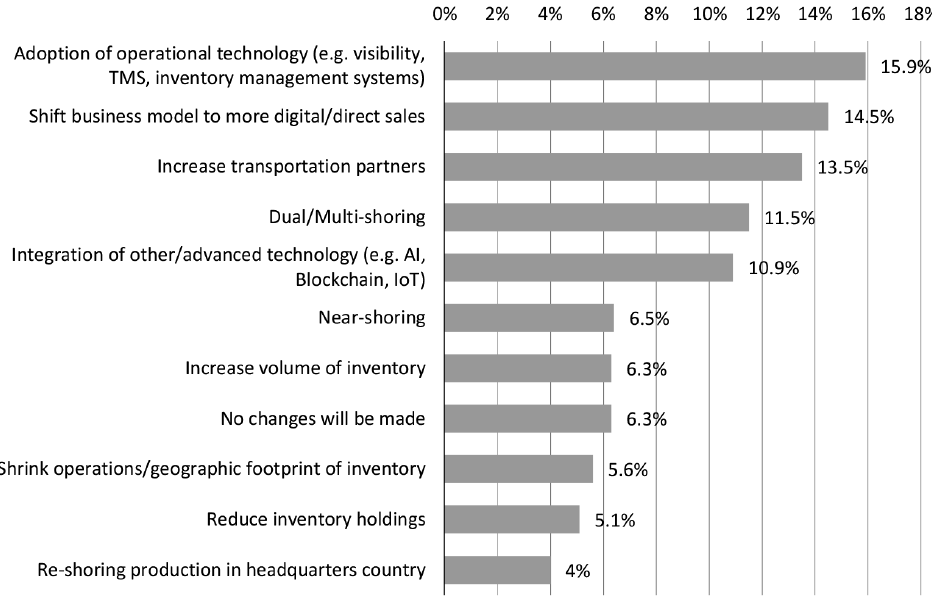
Figure 4. Proposed concepts, methods, and tools for Covid-19 post-pandemic